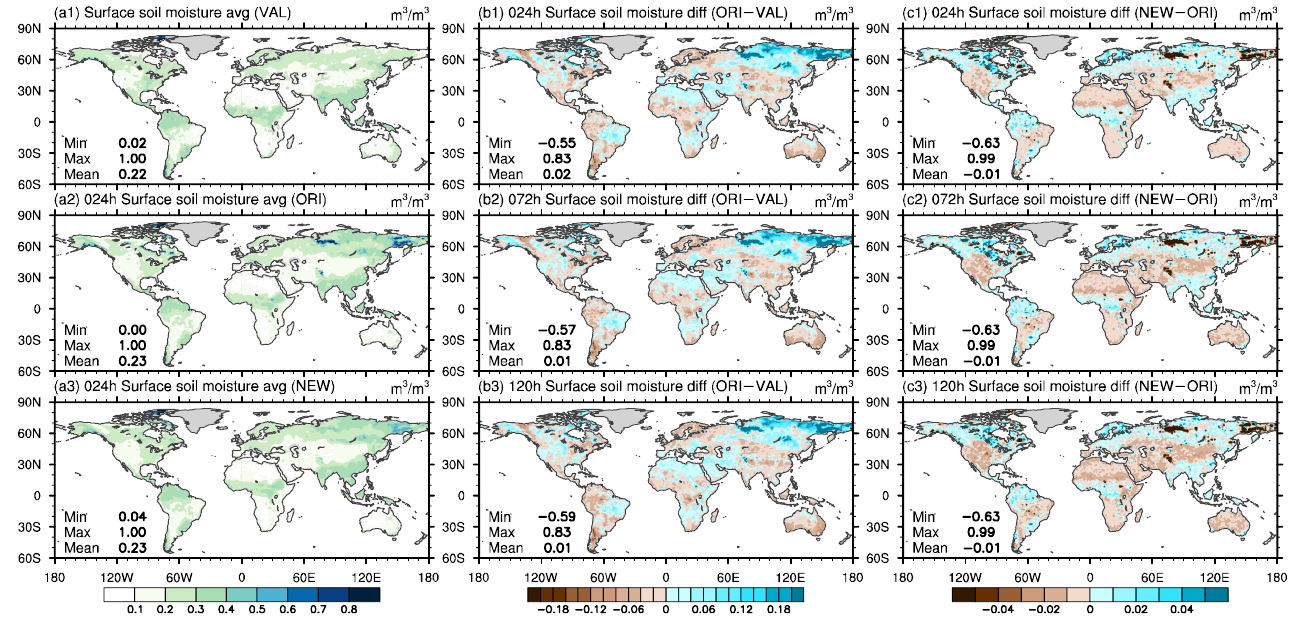
Figure 9. Spatial distribution of time-averaged surface soil moisture derived from ( a1 ) GLDAS dataset, ( a2 ) GRAPES_ORI 24 h forecast results, and ( a3 ) GRAPES_NEW 24 h forecast results; difference in time-averaged surface soil moisture between ( b1 ) GRAPES_ORI 24 h forecast results, ( b2 ) GRAPES_ORI 72 h forecast results, ( b3 ) GRAPES_ORI 120 h forecast results and GLDAS at the corresponding time; difference in time-averaged surface soil moisture between ( c1 ) GRAPES_NEW 24 h forecast results, ( c2 ) GRAPES_NEW 72 h forecast results, ( c3 ) GRAPES_NEW 120 h forecast results and GRAPES_ORI forecast results at the corresponding forecast lengths (units: m 3 · m − 3 ). Table 9. RMSE of surface soil moisture between GRAPES forecast and GLDAS over different regions (units: m 3 · m − 3